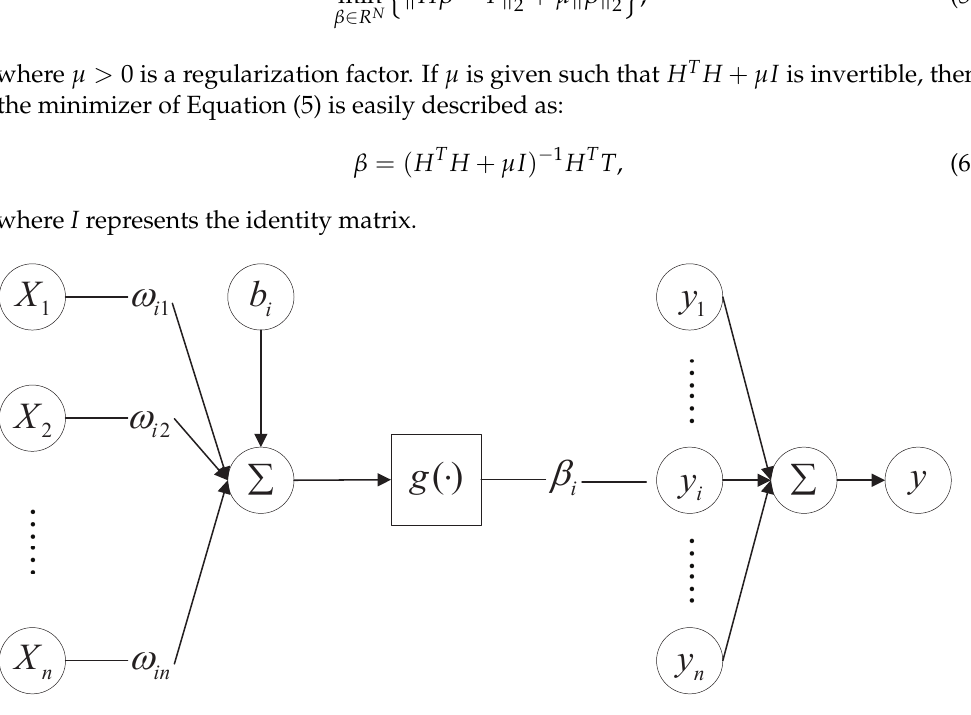
Figure 1. Mathematical model of FNNRWs. The convergence of the output weights of the unified learning model is provided by the FNNRW, which divides the whole training sample into many tiny subsets and utilizes each subset to create a local learning model to integrate the unified